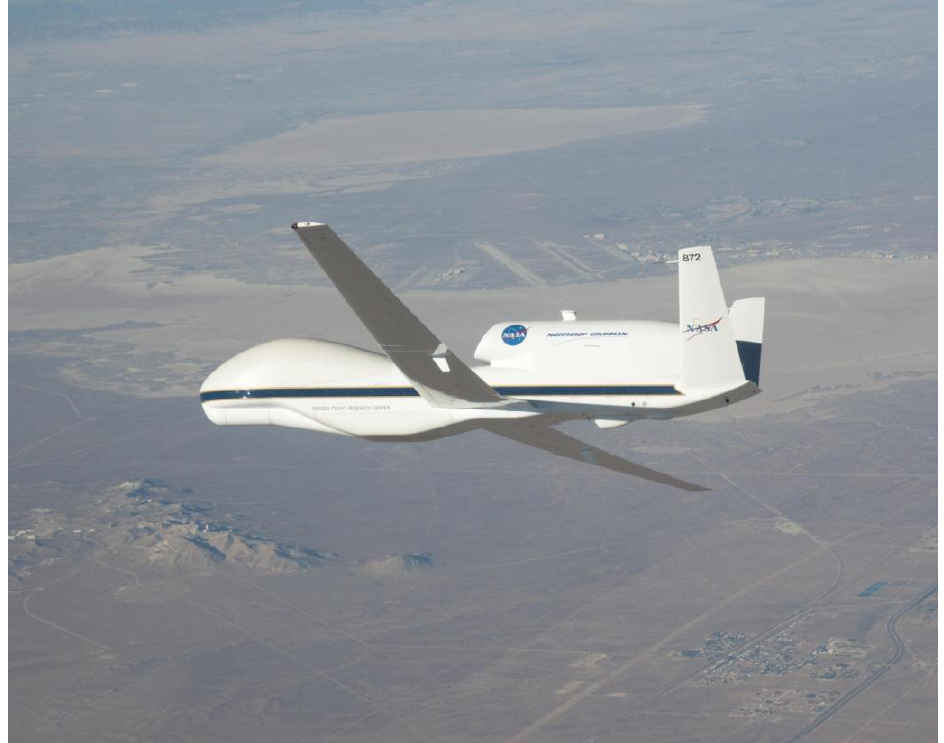
Figure 11. The NASA/NOAA Global Hawk HALE UAS. Image courtesy